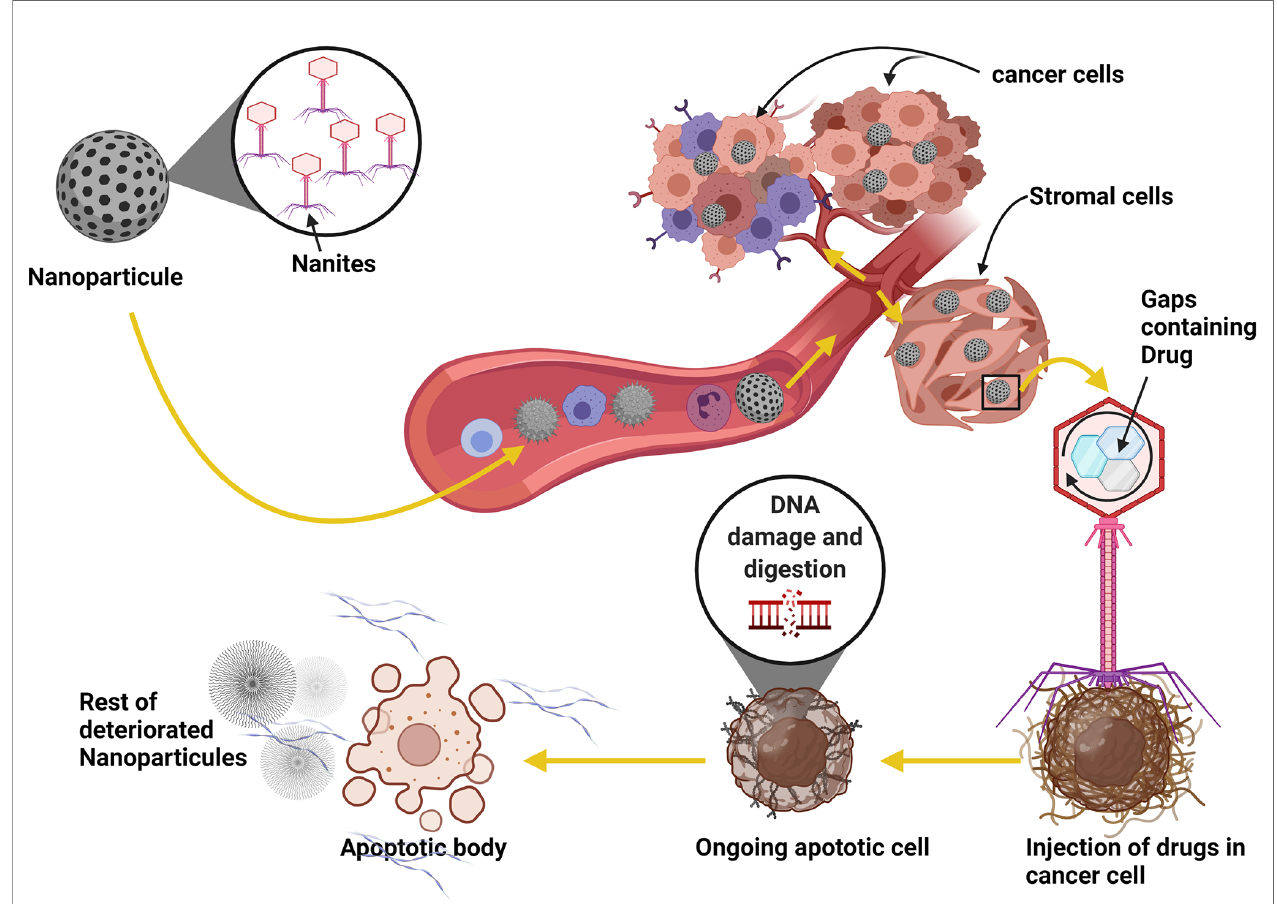
FIGURE 5 | Using nanoparticles as a parasite in cancer therapy strategy. Patients with brain cancer can take the nanites as a pill. The nanites will enter into the blood circulation system using the digestif way. Once in the blood, nanites will target the cancer cells, parasitize them and inject their contents into the cells, resulting in the death of the host cells and the degradation of fi brin necessary for developing blood vessels and the development of cancer. The virus also uses the same process to target its host cell. The use of this method can signi fi cantly improve patient life and reduce cancer